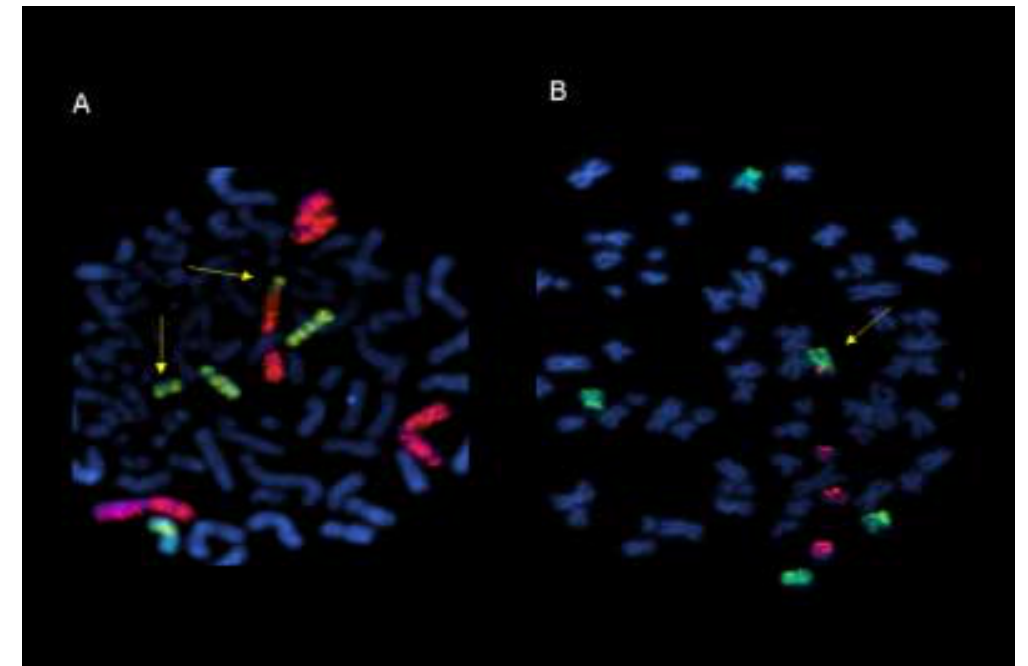
Fig. 2. Partial FISH results on the OV1/VCR cell lines. Hybridizations with WCP1 and WCP11 probes are shown, in red and green respectively, on the OV1/VCR.cont. cell line show the der(1)t(1;11) (arrow) (A). The der(8)t(8;13) is also presented (B) with hybridization of WCP8 (green) and WCP13 (red) probes. This figure can be viewed on